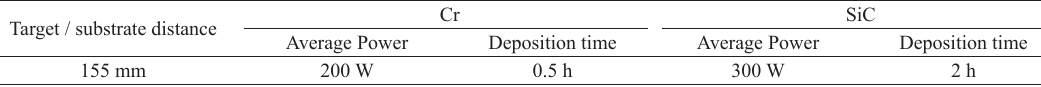
Table 2. Parameters used to deposit the SiC/Cr film on Ti-6Al-4V